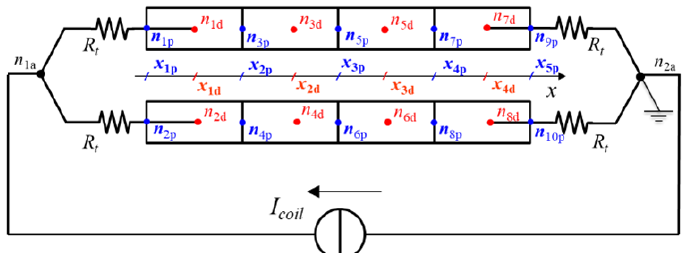
Figure A1. Schematic model of a composite conductor made of two filaments immersed in a conduct- ing matrix. The conductor is supplied with an impressed current I coil . The resistors needed to model the connection at the terminals of the conductor are also included in the